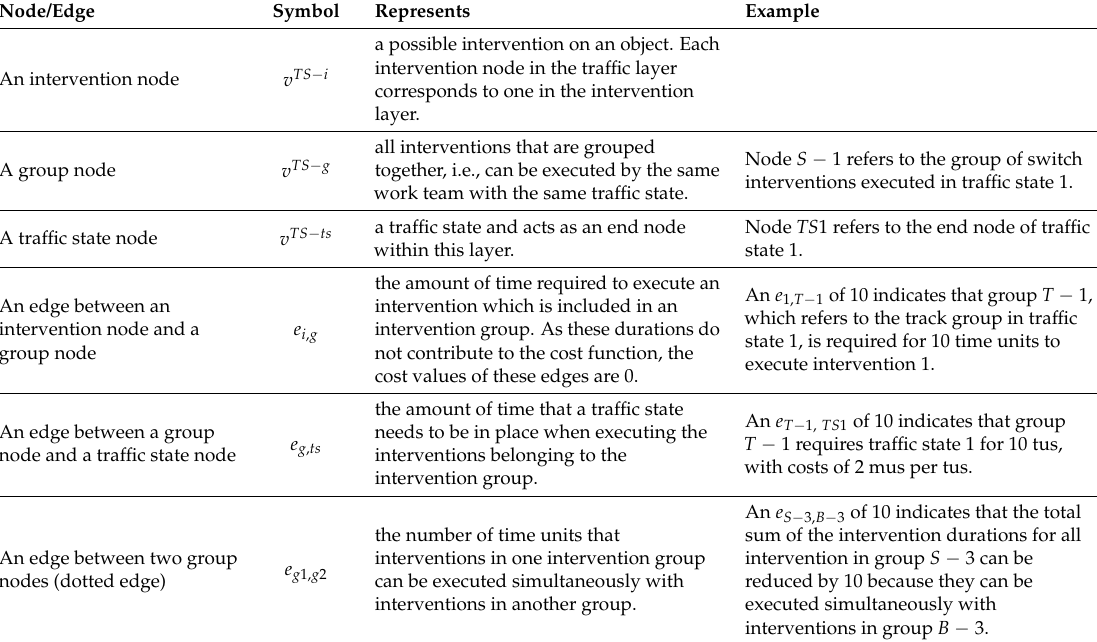
Table 4. Meaning of components of the model in the traffic state